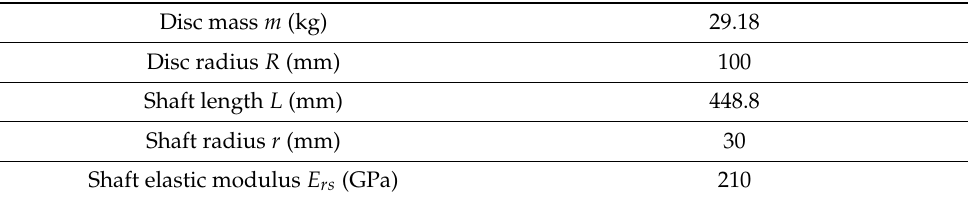
Table 2. Main parameters of rotor system [36].